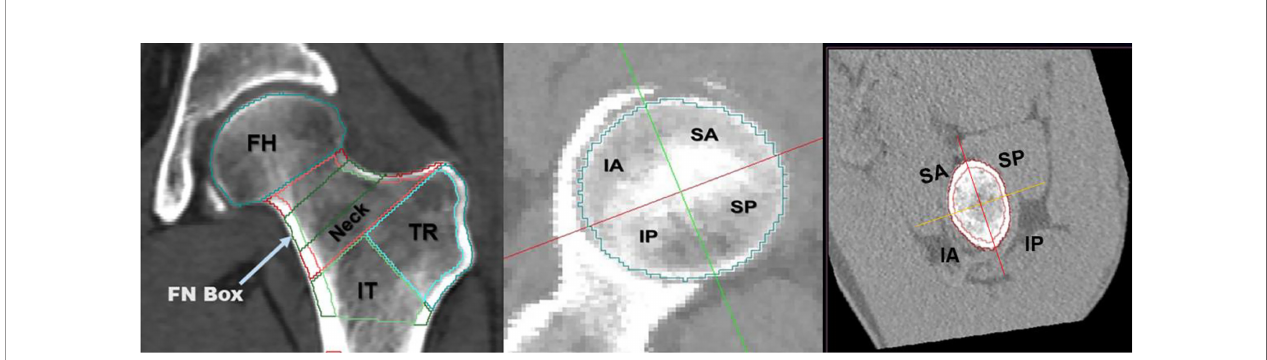
FIGURE 1 | Volumes of interest (VOIs) measured at the proximal femur by MIAF-Femur (left). Axial view along with the neck axis showing anatomic quadrants of femoral head (middle) and femoral neck (right). FH, femoral head; FN, femoral neck; TR, trochanter; IT, intertrochanter; SA, supero-anterior; IA, infero-anterior; IP, infero-posterior; SP,